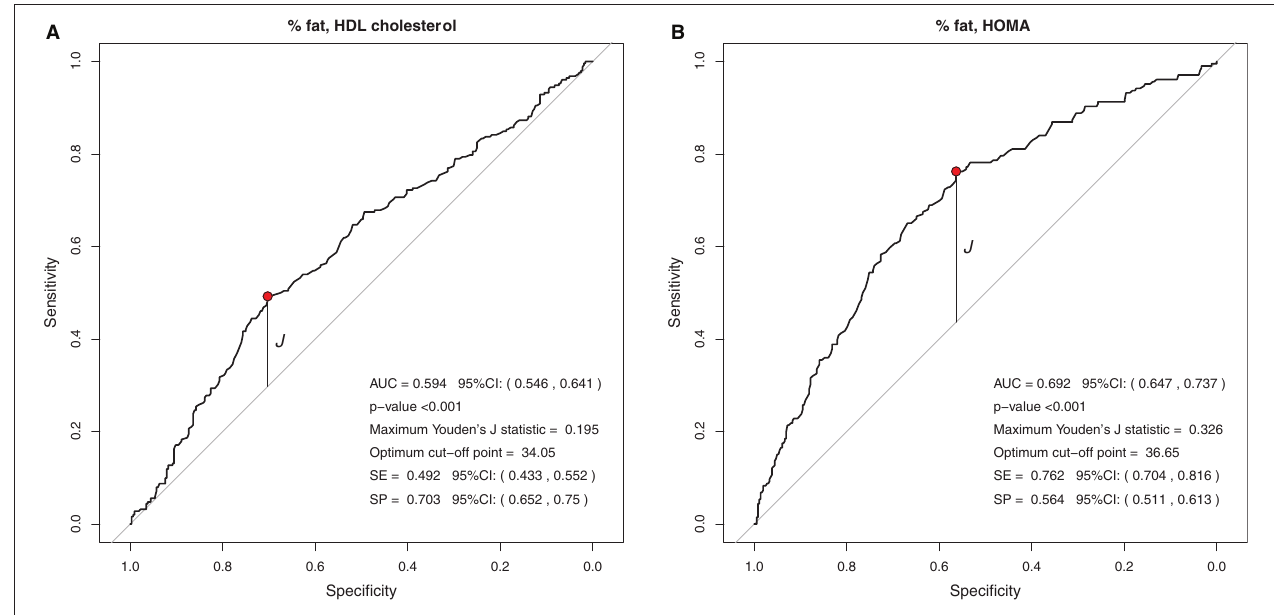
FIGURE 4 | (A,B) Suggested cutoff points for BFP, with greater ability to rule out changes in HDL-c levels and to predict changes in